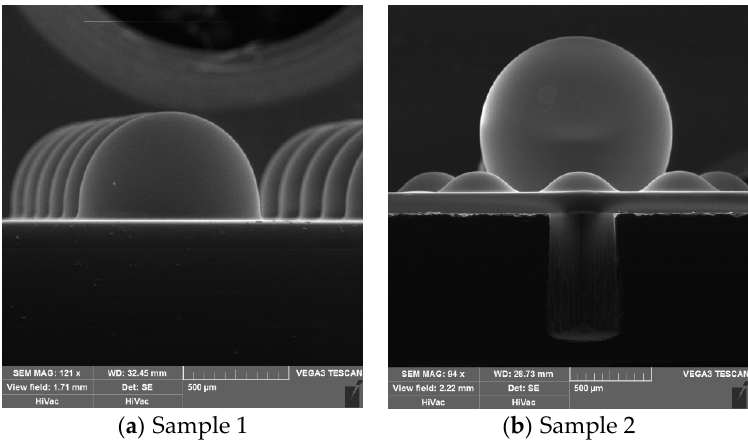
Figure 2. Scanning electron microscope (SEM) images of two different glass shells: ( a ) glass shell blown via an etched cavity without a foaming agent (H/D = 0.61); ( b ) glass shell blown via an etched cavity with quantified foaming agent (H/D = 0.80).